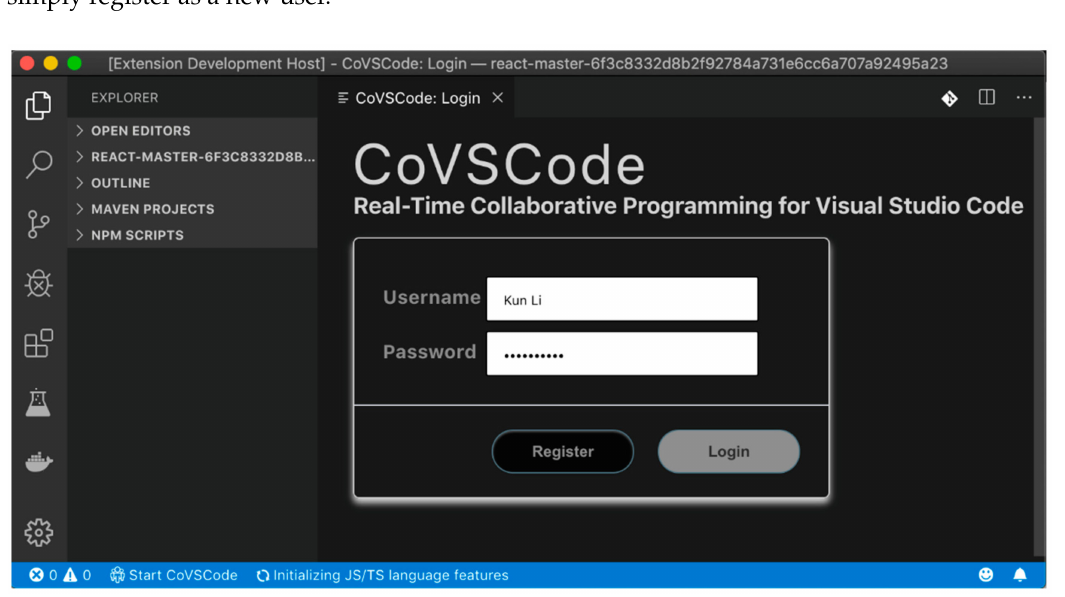
Figure 6. UI snapshot of the CoVSCode client’s login